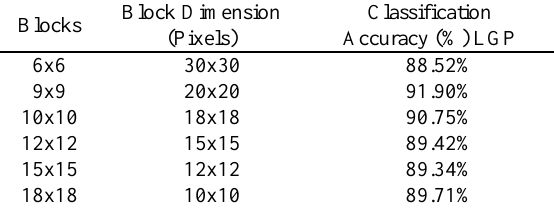
Table 2. Block Dimension vs. Classification Accuracy